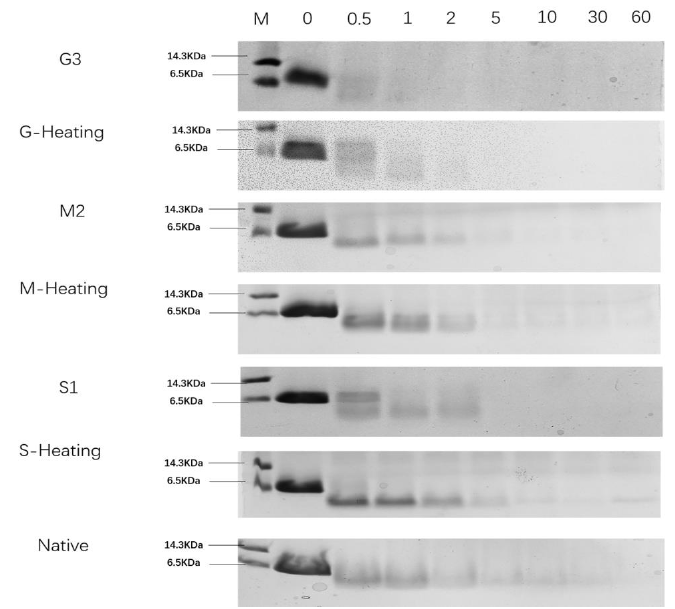
Figure 5. SDS-PAGE of Native and glycated parvalbumin heated by a microwave or an induction cooker in different pepsin digestion time. G3 (Glucose, 1.5 mol/L, 15 min), M2 (Maltose, 1 mol/L, 15 min), and S1 (Sucrose, 0.5 mol/L, 15 min) were heated by a microwave; G-Heating (Glucose, 1.5 mol/L, 15 min), M-Heating (Maltose, 1.5 mol/L, 15 min), and S1 (Sucrose, 1.5 mol/L, 15 min) were heated by an induction cooker. Native was unheated parvalbumin. MW Marker was indicated for lanes labeled